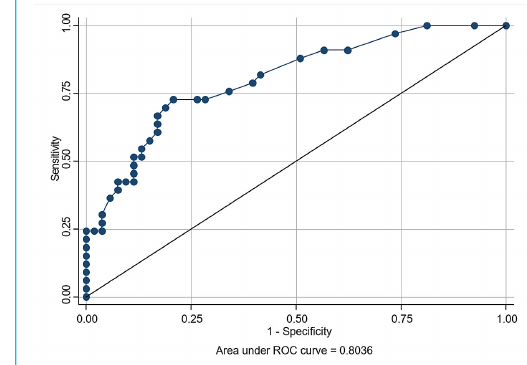
Figure 3: Receiver operating characteristic (ROC) curve of procal- citonin as strong predictor of the composite outcome (ICU admis- sion and/or mortality) with an area under the curve (AUC) of 0.80 (95% CI